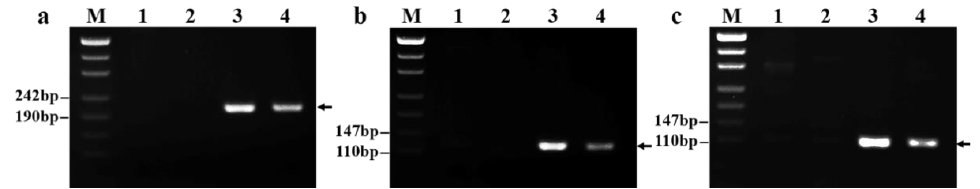
Figure 6. PCR amplification results of P. huashanica 7Ns chromosome-specific markers. ( a ) GPH7Ns-